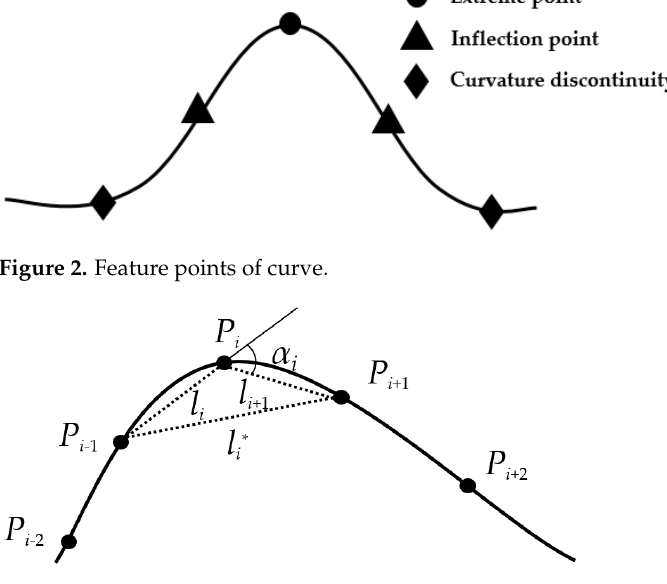
Figure 3. Schematic diagram of Formula (9) .